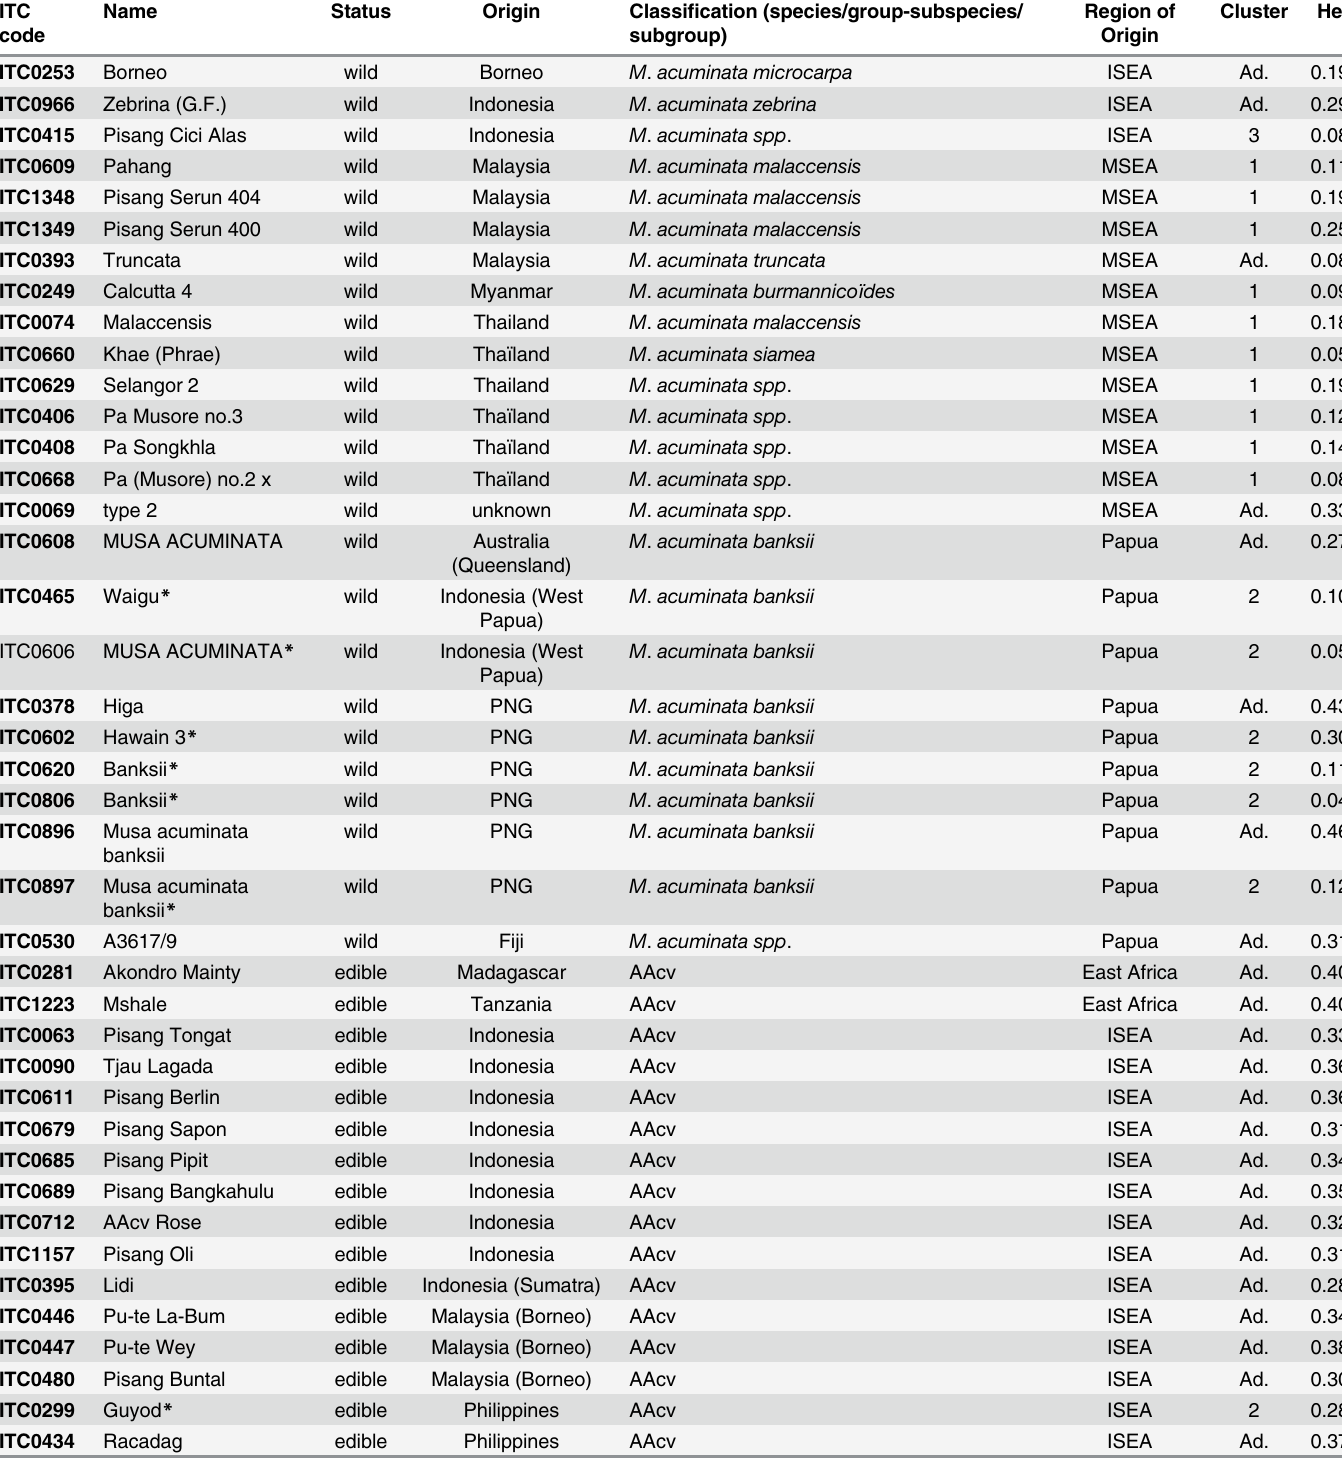
Table 1. List of the 105 accessions of the panel, their status, origins (PNG: Papua New Guinea, ISEA: Island-South-East Asia, MSEA: Mainland South-East Asia, NA: Not Applicable refers to synthetic hybrids), Clustering as detected by STRUCTURE (Ad.: Admixed accessions) and rates of observed heterozygosity